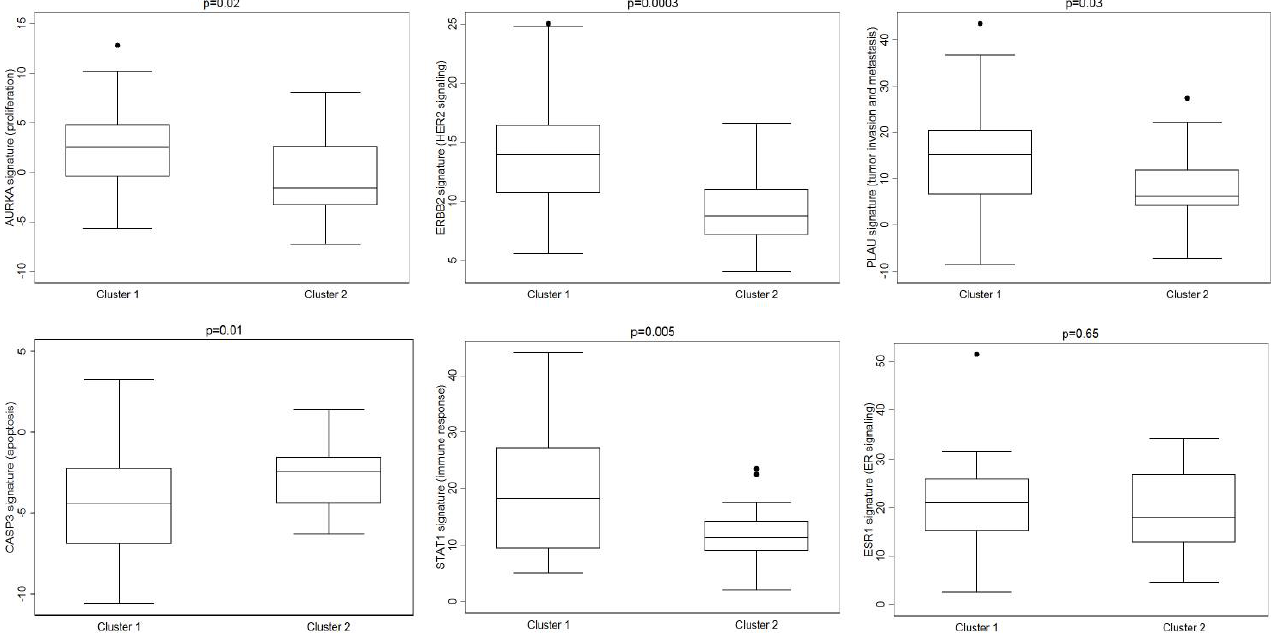
Figure 3. Gene–expression module signatures for key breast cancer biological processes were significantly different between Cluster 1 and Cluster 2 MBCs.